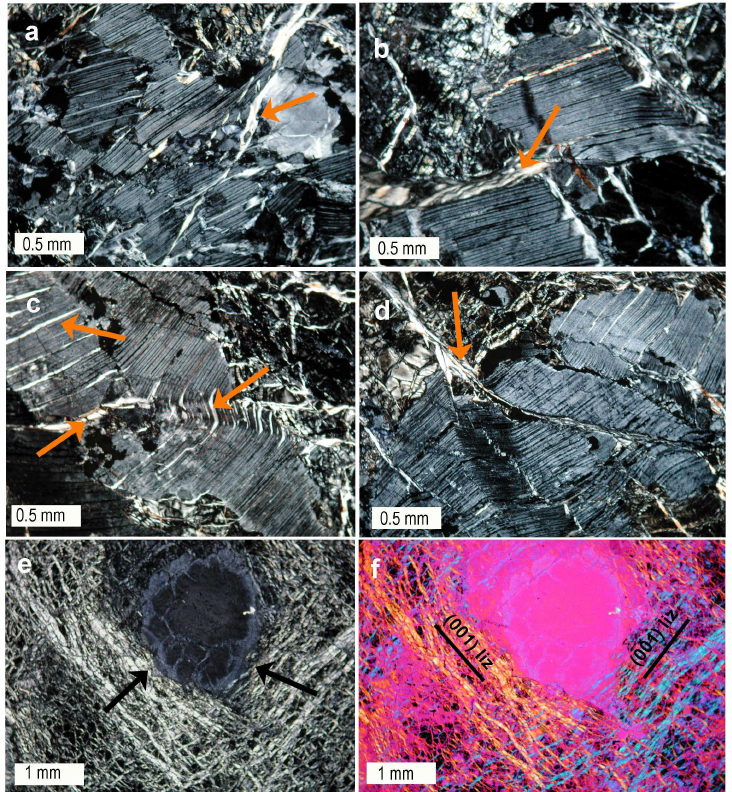
Figure 6. Deformation microstructures in bastites (polarised light images, crossed nicols). ( a , b ) Brittle fracturing of bastitic lamellae, with disaggregation and polymorph grain-size reduction. Note that bastites are crosscut by chrysotile veinlets (orange arrows). ( c , d ) Folding and kinking in bastitic lamellae, highlighted by the traces of pyroxene cleavage planes. Cleavage traces are typically filled by chrysotile veinlets that favour cleavage-parallel sliding of bastite “slices”. ( e ) Influence of bastite on the deformation of surrounding meshes. Black arrows indicate local overstress at the bastite edges on nearby mesh cells. ( f ) Corresponding image with the retardation gypsum plate, showing preferential dissolution of lizardite sectors with (001) planes perpendicular to bastite edges.